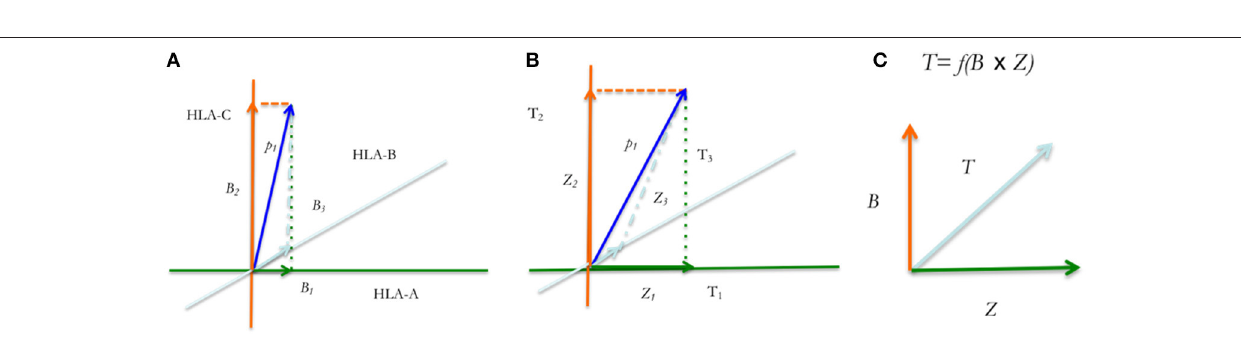
FIGURE 5 | Tissue injury releases polymorphic recipient mHA from epithelial cells (EC); these and endogenous antigens are presented by APC; the APC proliferate and migrate to the lymph node triggering a CD4 + and CD8 + T cell clonal expansion according to the logistic equation of growth. These T cell clones then enter the circulation and migrate to the tissues to initiate tissue injury. Short black arrows in the oval (lymph node) below H1P1 and TCR1 indicate affinity vectors B and Z respectively.